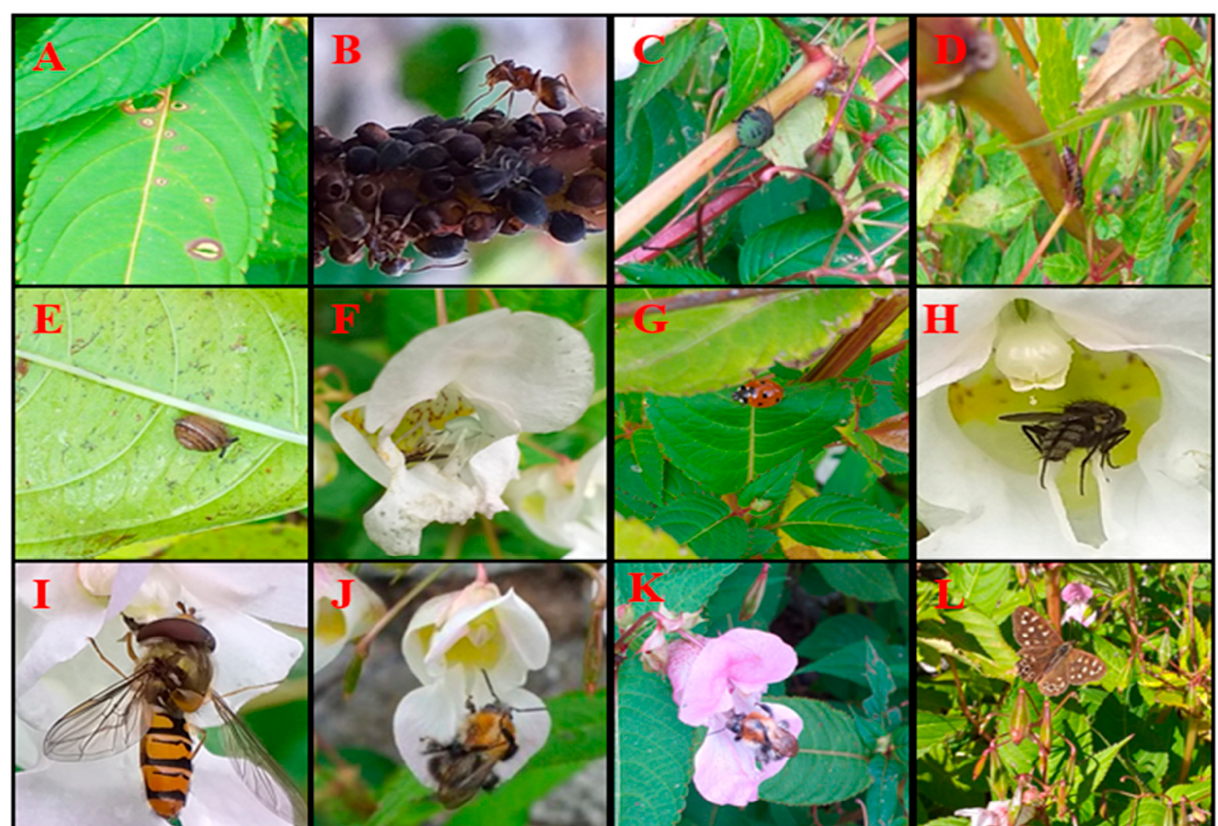
Figure 2. Invertebrate communities associated with I. glandulifera are said to be impoverished and though I. glandulifera is considered to be free of natural enemies which constrain its growth in the invaded range, it is not devoid of visitors [42] . Herbivory can be observed on the leaves ( A ), both pollinators and phytophagous insects (see Aphis fabae ( B ), Palomena prasine ( C ) and Dermaptera ( D )) are observed to visit I. glandulifera . Gastropods ( E ) of all sizes can be observed on the stems, leaves and even inside the flowers of I. glandulifera . Multiple species of spiders can be observed casting webs between flowering stems, or even found, as is the case for Misumena vatia , residing inside its flowers ( F ). In addition to Palomena prasine , other beetles, such as Coccinella septempunctata ( G ), visit I. glandulifera as well as various flies, including Sarcophagidae species ( H ). Many hoverfly species, including Episyrphus balteatus ( I ), can be seen feeding on the pollen of I. glandulifera , while bumblebee species prefer the rich nectar of this invasive. Pollinators can often be seen grooming copious amounts of pollen off themselves upon leaving the flowers of I. glandulifera ( J ). Multiple Bombus species visit the flowers of this invasive- including Bombus hypnorum ( K ). Several butterfly species also visit this invasive- including Pararge aegeria ( L